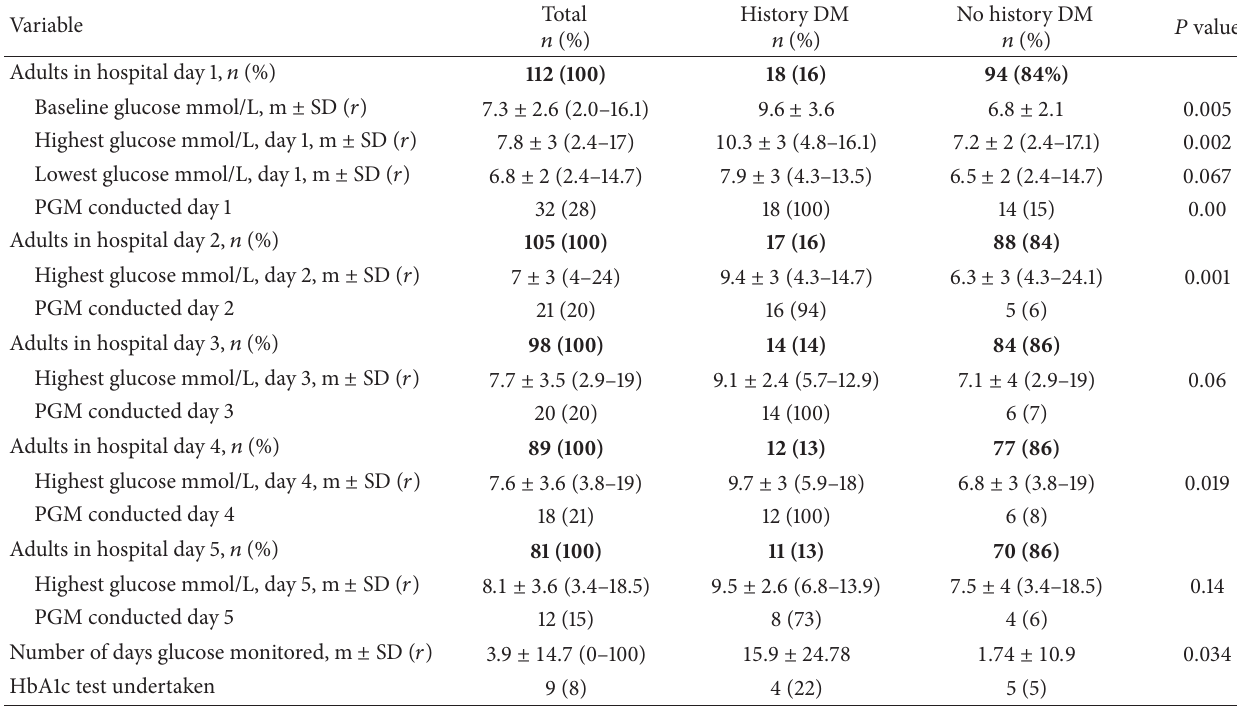
Table 2: Glucose results (mmol/L) and glucose monitoring practice and comparison between adults grouped by history of diabetes and no history of diabetes